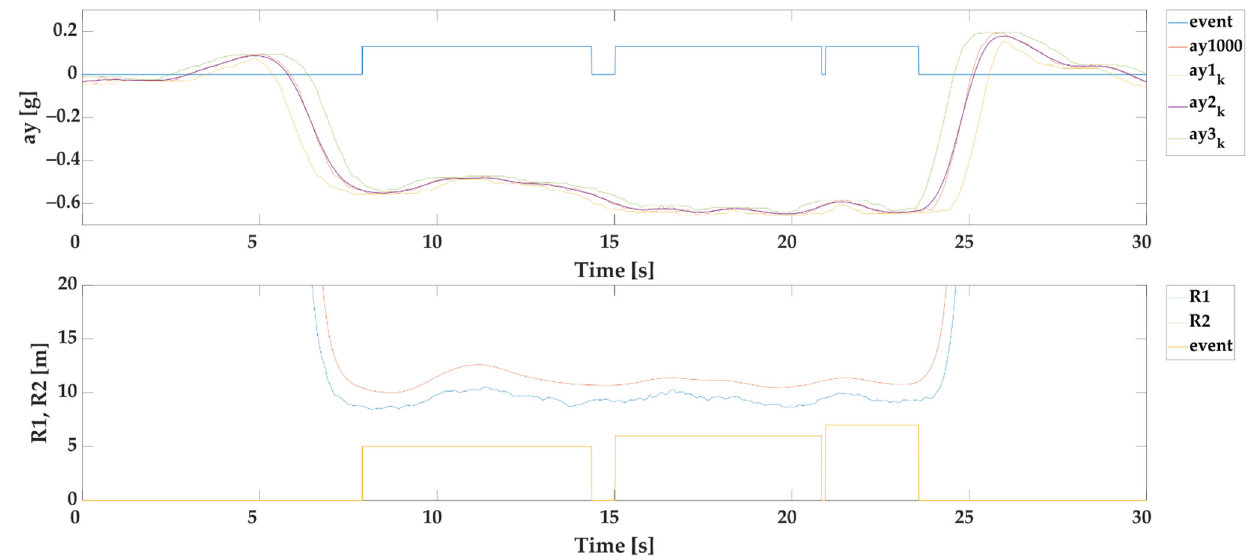
Figure 3. Example of automatic selection of events based on stable lateral accelerations.